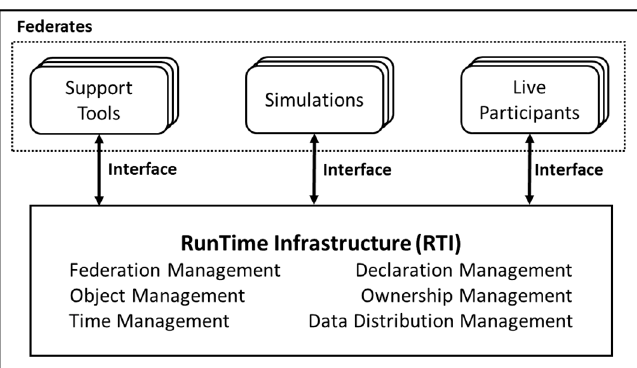
Figure 2. Functional view of an HLA federation.